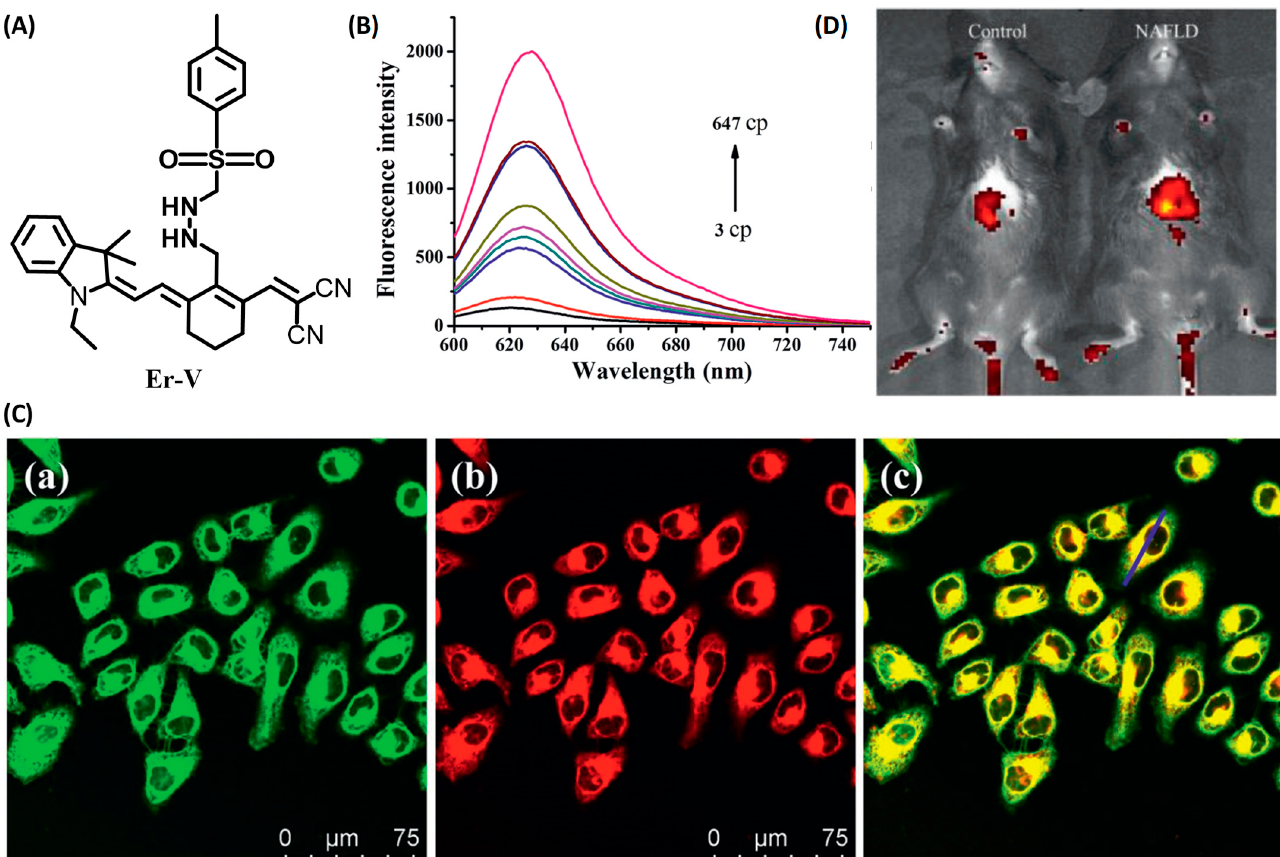
Figure 4. ( A ) The structure of the probe Er-V . ( B ) Changes in the fluorescence of Er-V (5.0 µ mol/L) in different methanol–glycerol systems. λ ex = 580 nm, λ em = 626 nm. ( C ) Colocalization fluorescence images of HL-7702 cells stained with Er-V and ER commercial dye. (a) Fluorescence image from ER commercial dye ( λ ex = 488 nm, λ em = 495–550 nm). (b) Fluorescence image from Er-V ( λ ex = 561 nm, λ em = 580–700 nm). (c) The overlay images of image (a) and (b). ( D ) In vivo fluorescence images of the livers of mice in the NAFLD model [33]. Copyright © 2023 Elsevier B.V. All rights reserved.